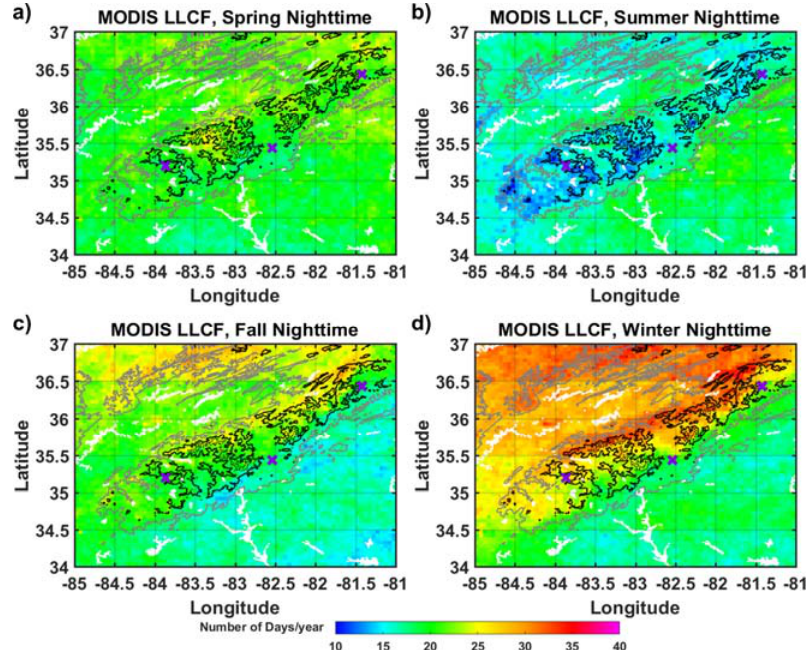
Figure 14. Spatial distributions of MODIS LLCF (CTH <5 MSL, confident cloudy only) occurrences in each grid box (0.05° × 0.05°) during nighttime overpasses in each season (spring: April–June; ( a ) summer: July–September; ( b ) fall: October–December; ( c ) and winter: January–March; ( d ) Contour lines mark terrain elevation of 500 m (solid grey), 1000 m (solid black) and 1500 m (dotted black) and water surface is delineated by white dots. Note the three ground ceilometer sites (from left to right: KRHP, KAVL, and KGEV) are marked by purple crosses.